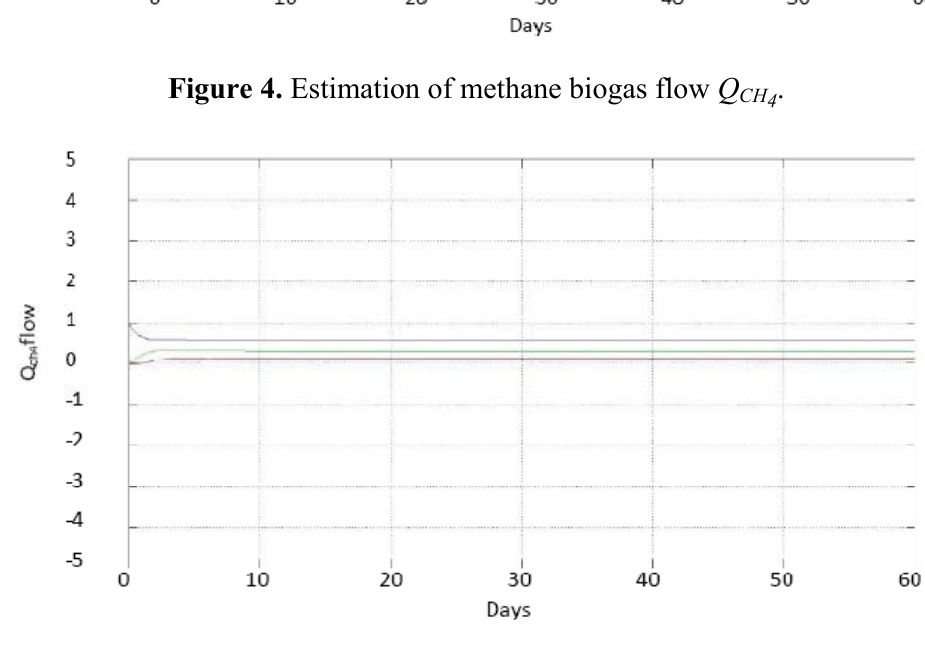
Figure 4. Estimation of methane biogas flow Q